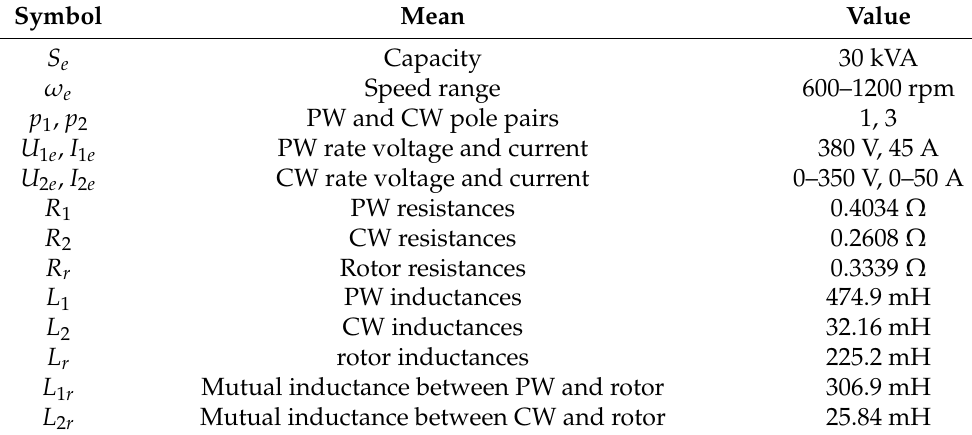
Table 1. The parameters of the BDFIG.